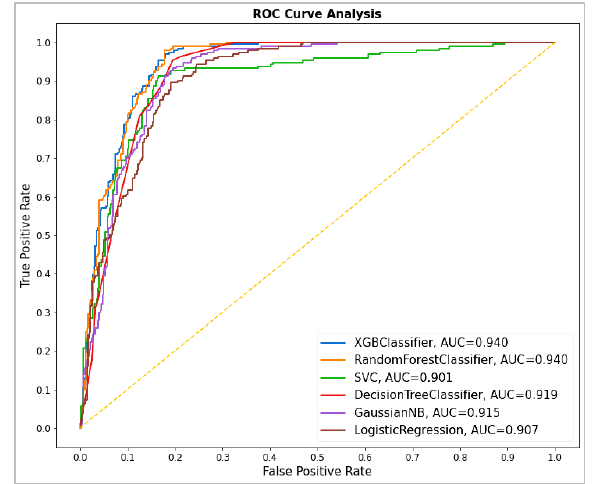
Figure 7. ROC Curve Analysis with AUC score comparison between used ML algorithms after Undersampling algorithm or evaluation procedure or differences in numerical